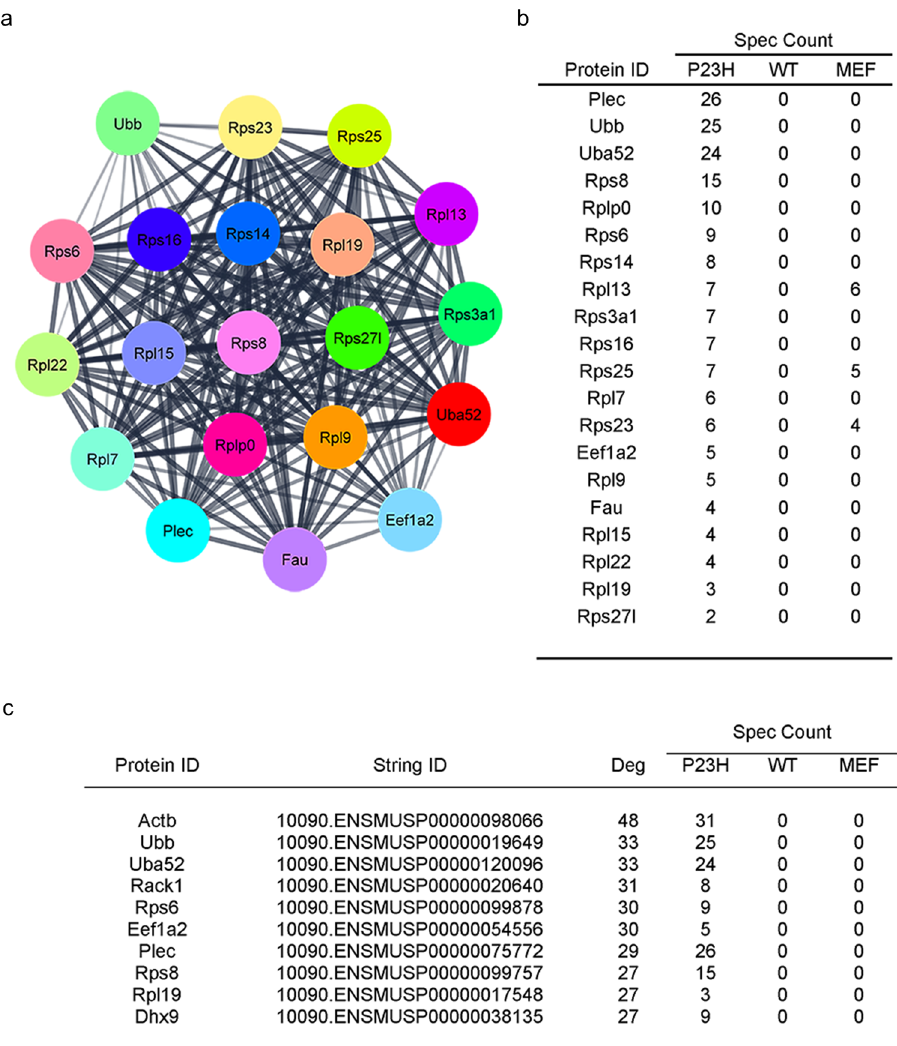
Figure 4. Protein–protein interaction analysis of the P23H rhodopsin interactome. ( a ) The P23H rhodopsin interactome PPI network was assembled using STRING, and MCODE was used to identify the most significant PPI module within the STRING network. The most significant PPI module (MCODE value = 21) within the P23H Rhodopsin interactome is shown. ( b ) The 20 proteins in this module and their spectral counts are listed. ( c ) Cytohubba was used to quantify the connectivity of all proteins in the P23H rhodopsin interactome STRING network, and the 10 proteins with the highest degree of connectivity and their spectral counts are